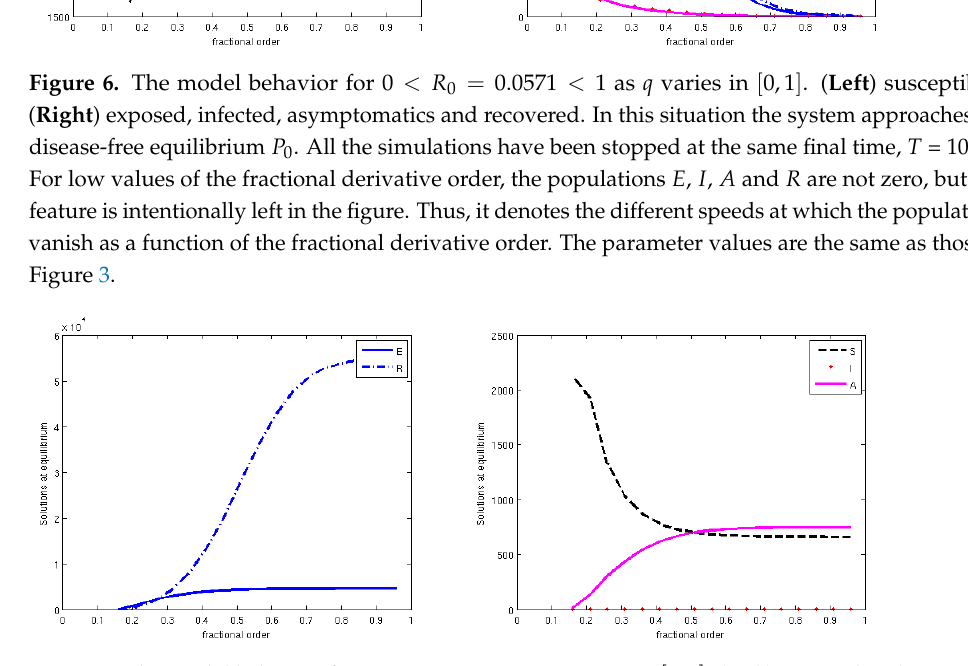
Figure 7. The model behavior for R 0 = 1.2677 > 1 as q varies in [ 0,1 ] . ( Left ) exposed and recovered; ( Right ) susceptibles, infected and asymptomatic. Once again the system settles at the endemic equilibrium, but this time we have ξ = 0 and α = 1, so that the point attained is P I . The parameter values are the same as those in Figure